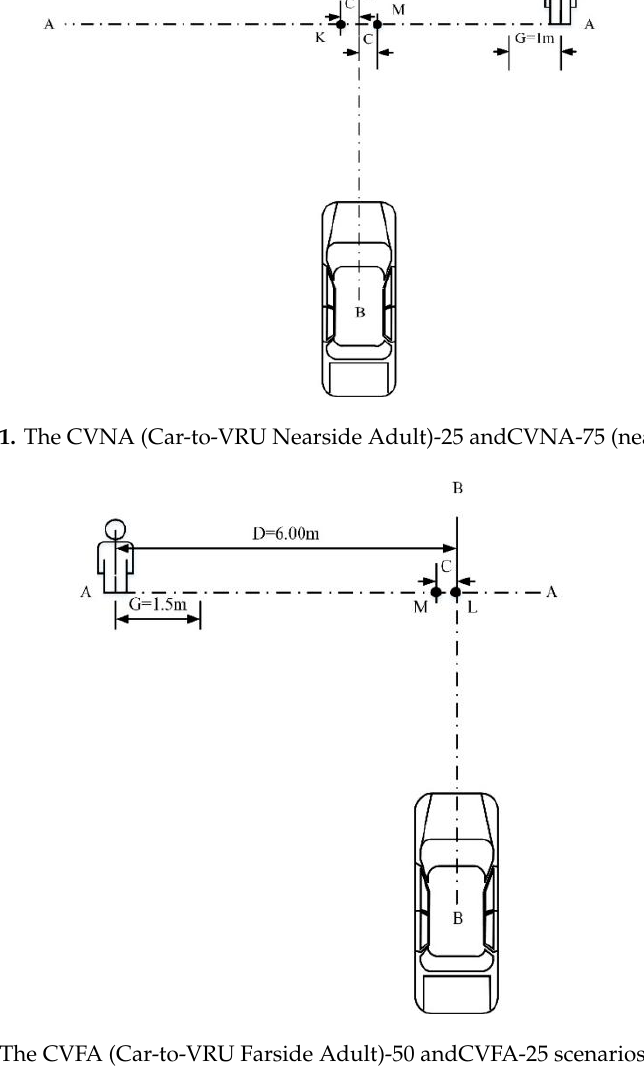
Figure 22. The CVFA (Car ‐ to ‐ VRU Farside Adult) ‐ 50 andCVFA ‐ 25 scenarios (far ‐ end).